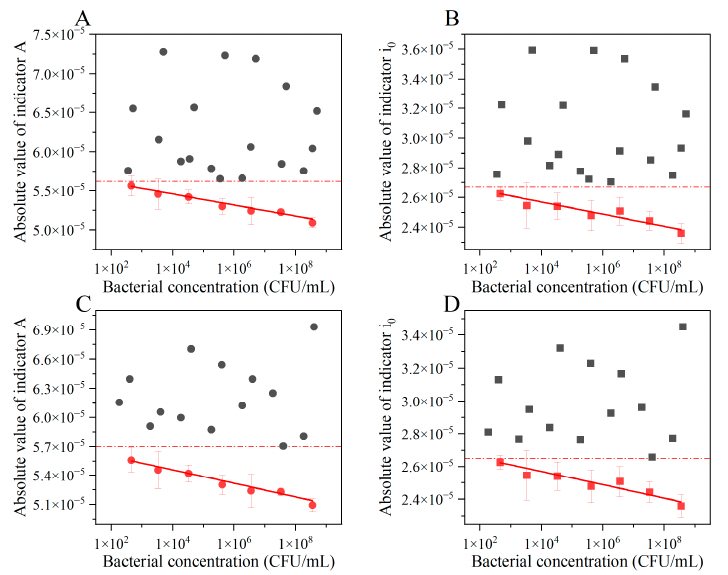
Figure 3. Influence of dead bacteria on the electrochemical response indices under different electrode systems. ( A ) Electric quantity index and ( B ) electric current index values when analyzing bacterial lysates after ultrasonic disruption; ( C ) electric quantity index and ( D ) electric current index values to detect bacterial structure after glutaraldehyde fixation. Black symbols indicate the concentration of original bacterial cells before the dead bacteria inactivation treatment, and red symbols indicate the concentration of viable bacteria; there was a significant difference between dead bacteria and live bacteria response